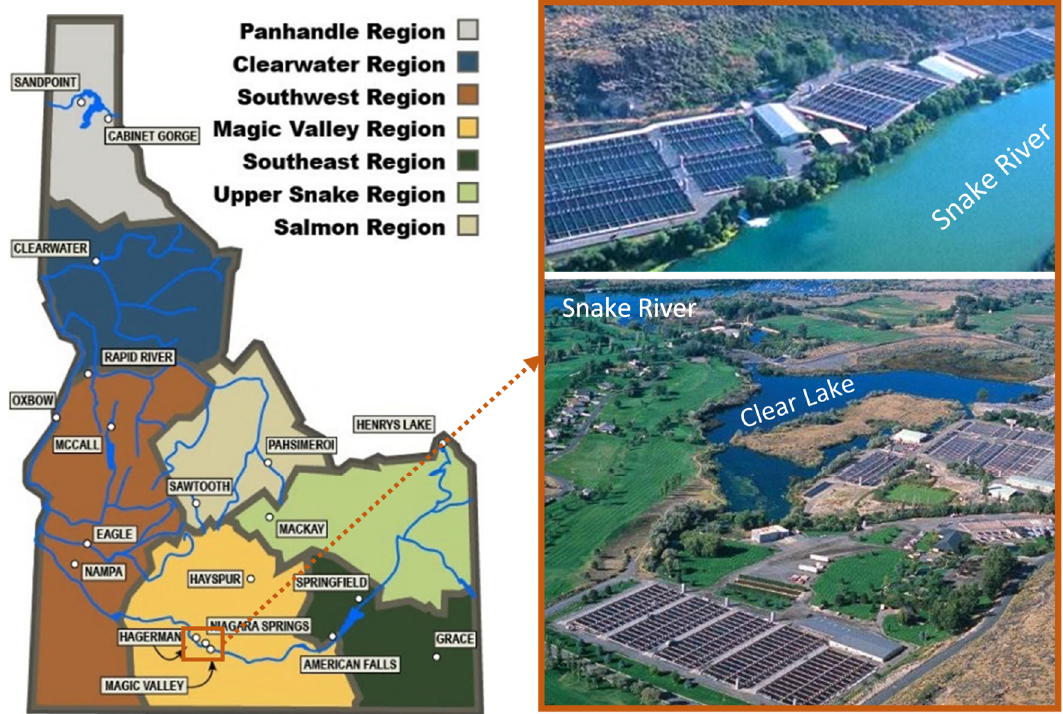
Figure 1. Aquaculture regions in Idaho and fi sh farm facilities in Magic Valley, Southern Idaho.